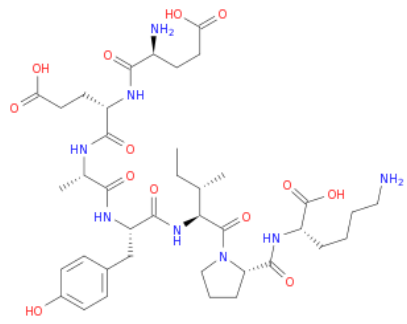
Figure 20. Chemical structure of hGH. Formula: C 19 H 26 O 3.